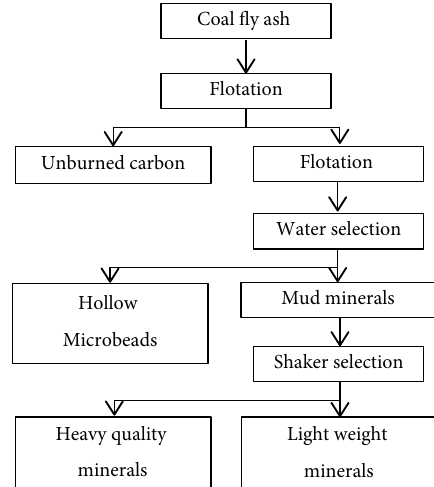
Figure 3: Physical selection test procedure for the coal fly ash.